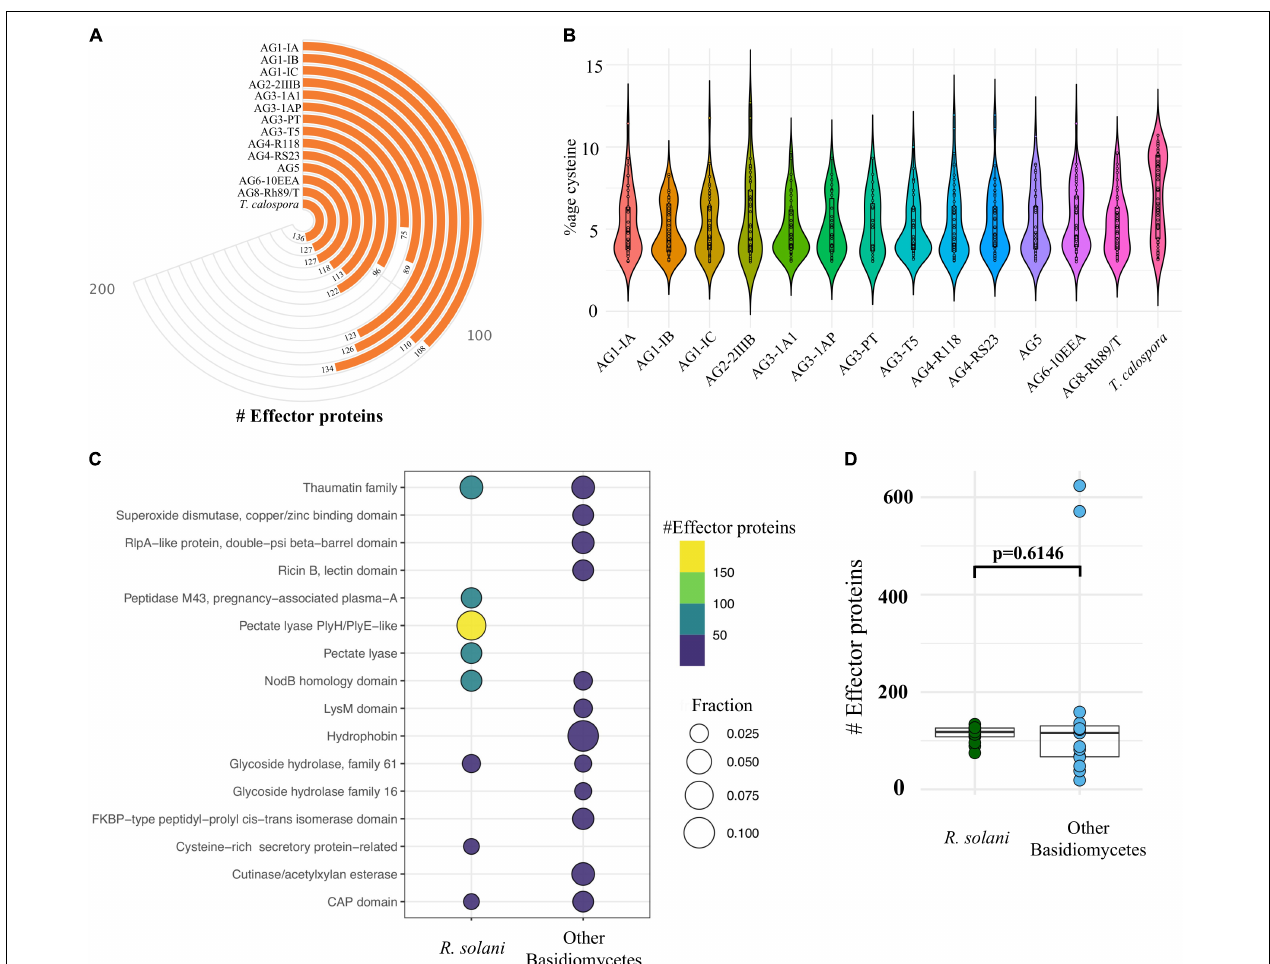
FIGURE 5 | Effector proteins. (A) The number of cysteine rich effector proteins predicted in the predicted secretome of each fungal isolate. (B) The proportion of cysteine observed across all the effectors predicted in each isolate. (C) Topmost enriched InterPro domains in effector proteins of Rhizoctonia species (not T. calospora ) and other Basidiomycetes (including T. calospora ). (D) The comparative analysis of the distribution of number of effector proteins predicted in R. solani AGs as compared to other Basidiomycetes. The p -value is computed using the unpaired Wilcoxon-rank sum